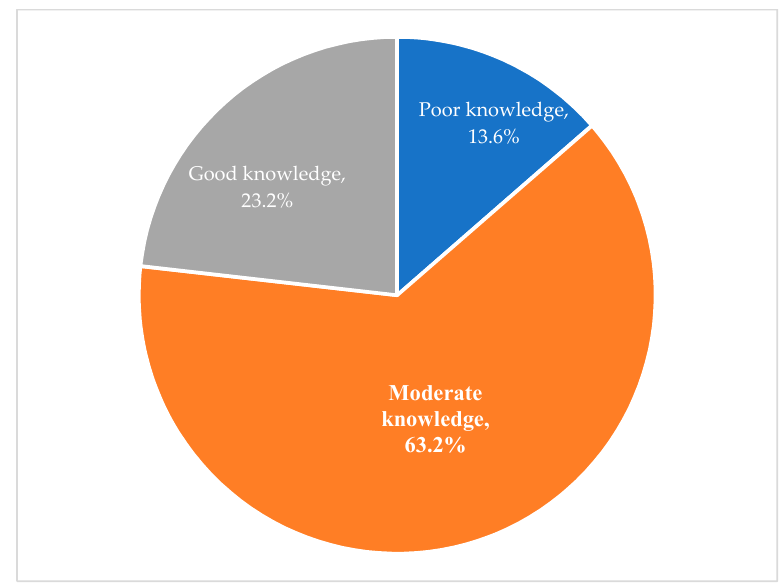
Figure 1. Knowledge about food allergy of parents.